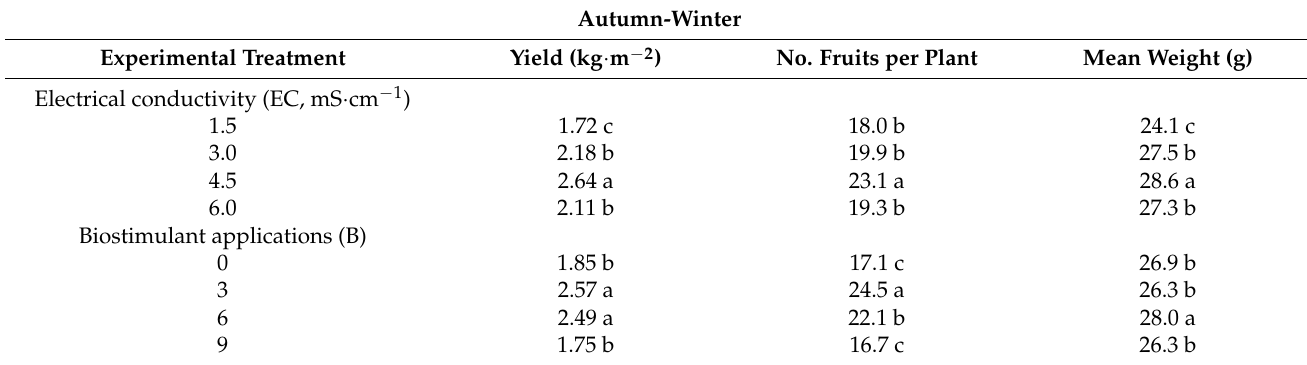
Table 1. Yield and growth parameters of tomato fruits as affected by soil EC and number of biostimu- lant